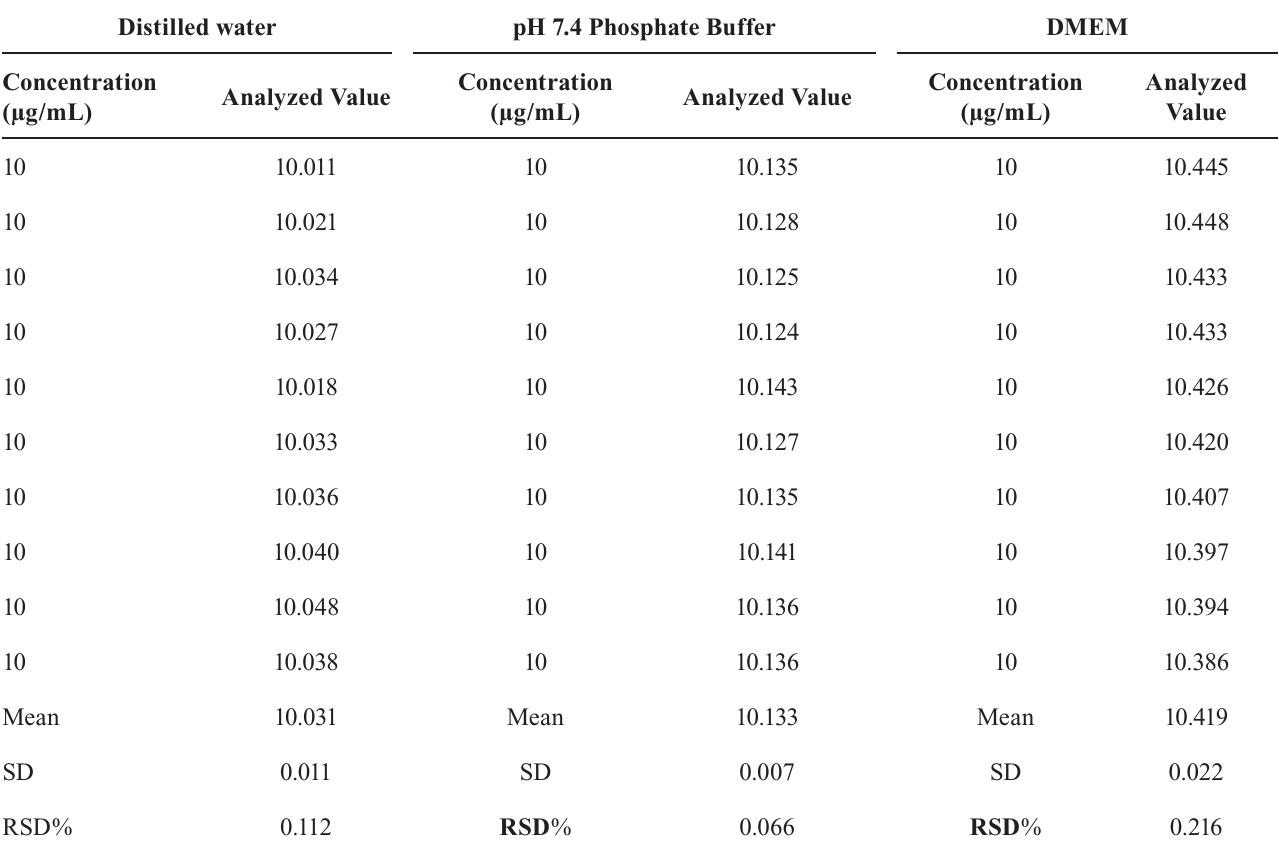
Distilled water pH 7.4 Phosphate